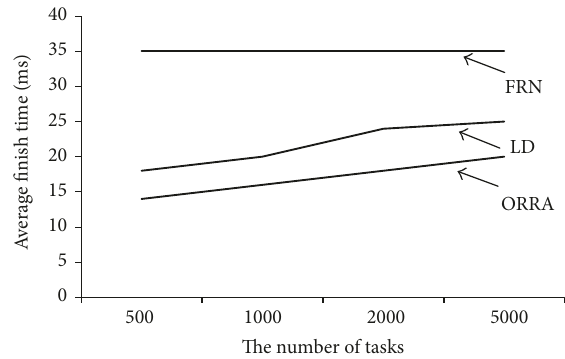
Figure 3: Average access latency with number 𝐼 of replicas.